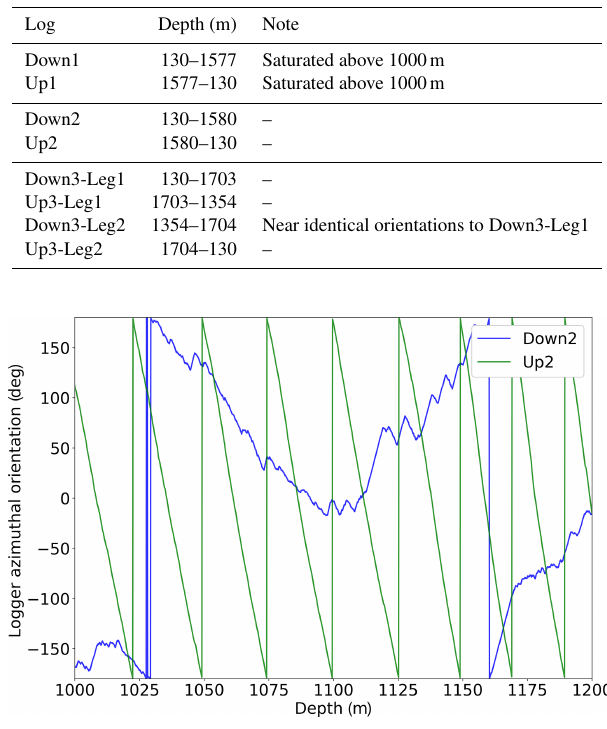
Figure 3. Rotation of the tool descending and ascending the bore hole. A smooth and continuous rotation of slightly varying angu- lar velocity is observed when ascending. During descent, the rota- tional movement is erratic. (The azimuthal orientation is with re- spect to local grid bearings. Grid north (0 ◦ ) aligns with the Green- wich